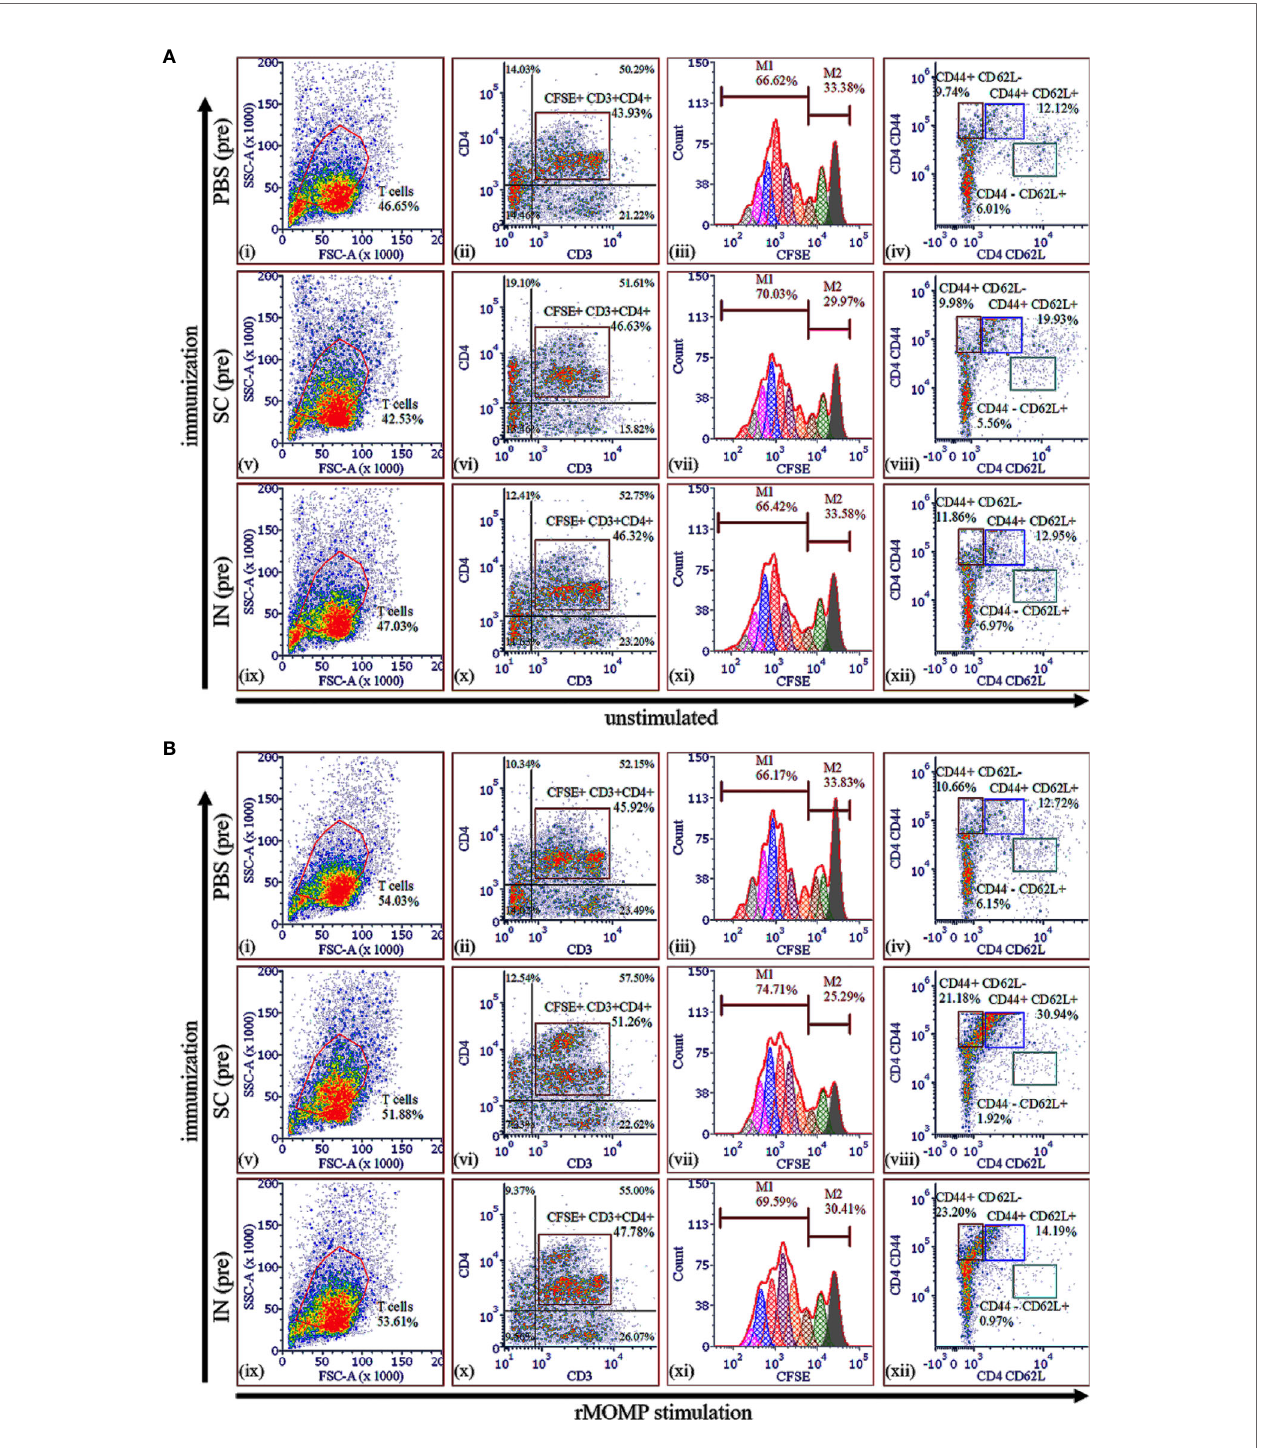
FIGURE 4 | Chlamydia -speci fi c T-cell proliferation and memory and effector T-cells in PLGA-rMOMP immunized and challenged mice. Puri fi ed T-cells (1×10 6 ) labeled with fl uorescent CFSE dye were co-cultured with mitomycin-C treated APCs (1×10 6 ) and stimulated with rMOMP (5 m g/mL) for 120 h at 37°C in a 5% CO 2 humidi fi ed atmosphere. Co-cultures were centrifuged, and cells were stained with fl uorochrome-labeled speci fi c antibodies for CD3, CD4, CD44 and CD62L surface markers. Cells were acquired on a fl ow cytometer and analyzed by gating on CD3 + T-cells with secondary gating on CFSE + CD3 + CD4 + T-cells for proliferating memory (CD44 + CD62L + ) and effector (CD44 + CD62L - ) T-cell phenotypes. Immunized mice (pre), unstimulated (A) and, rMOMP stimulation (B) . Proliferating T-cells (M1) and non-proliferating T-cells